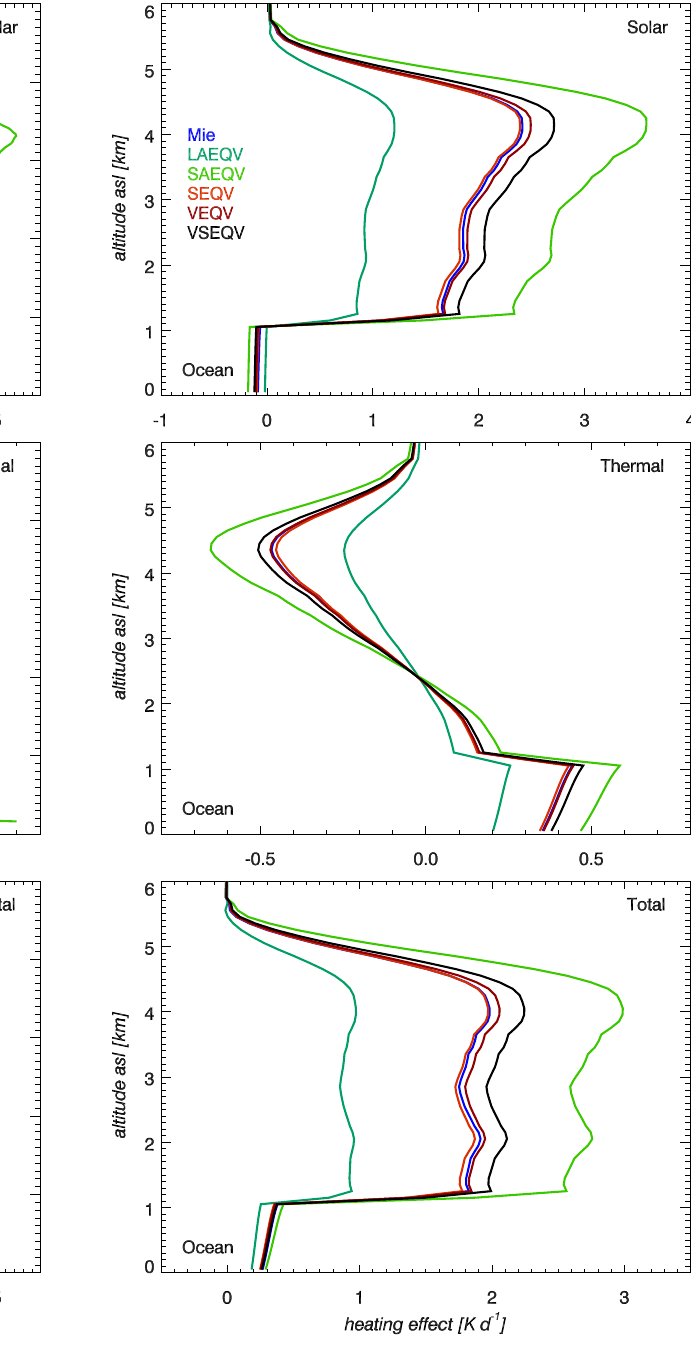
Fig. 19. Simulated heating effects 1H(z) by Eq. (4) of the Saha- ran mineral dust plume, observed on 19 May 2006 over OZT site about noon, lifted over a mean ocean surface assuming spherical (Mie) and prolate spheroidal model particles for various cases of size equivalence (LAEQV, SAEQV, SEQV, VEQV and VSEQV), representative for solar (top), thermal (centre) and total (bottom) spectral